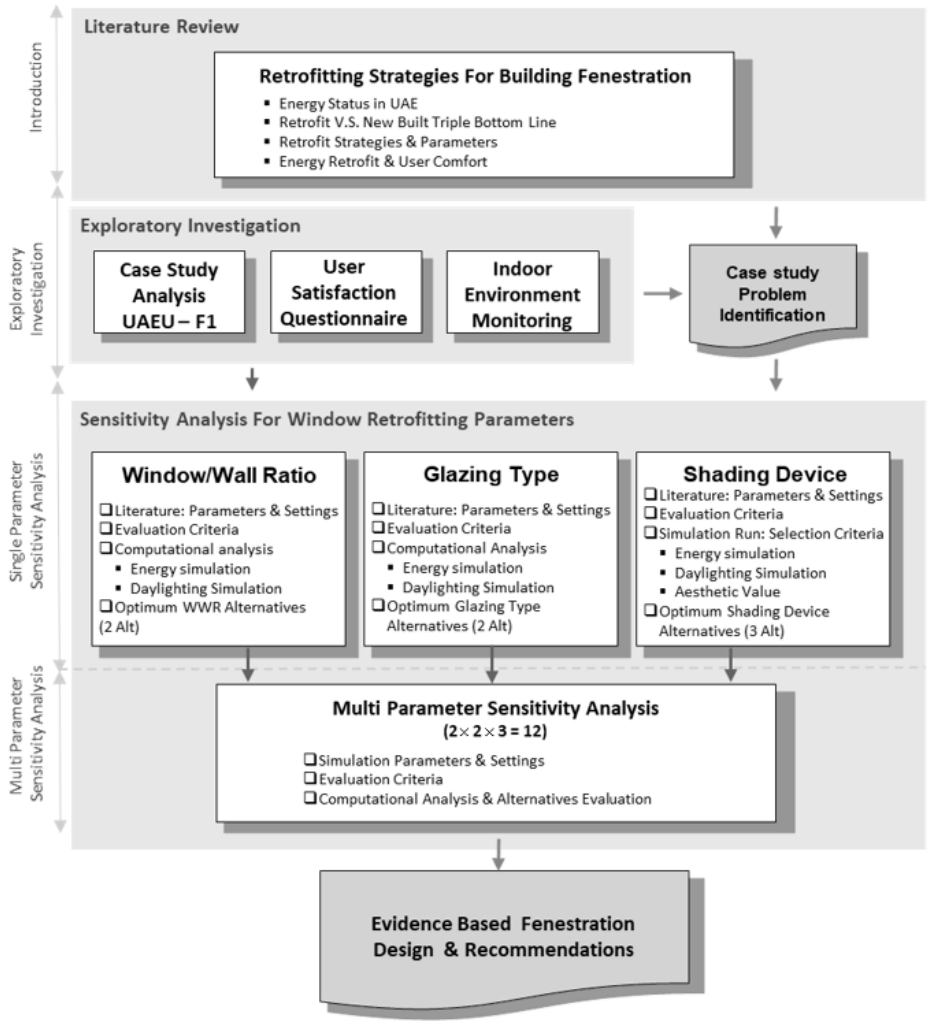
Figure 1. Research design used for the study. Source: the authors.